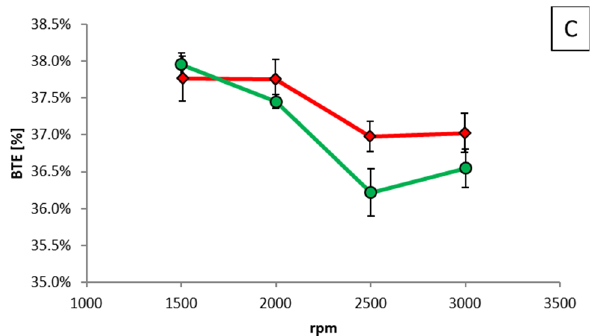
Figure 16. BTE as a function of engine speed for different fixed brake torques of ( A ) 50 Nm, ( B ) 75 Nm, and ( C ) 150 Nm.